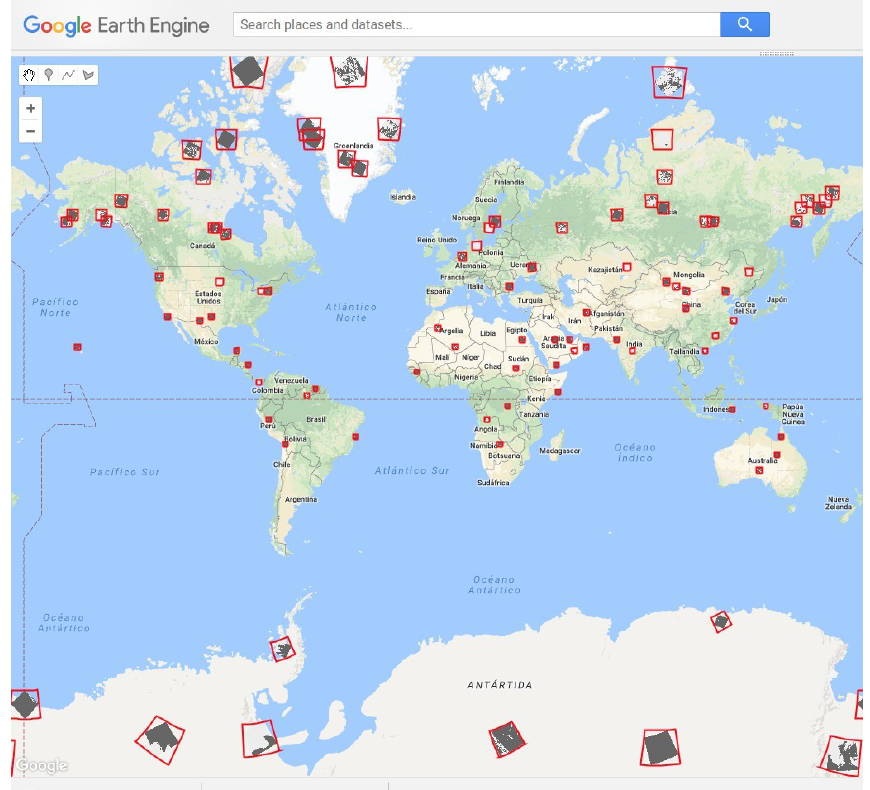
Figure 1. Geographic location of the 96 images from the Landsat-8 Biome dataset [31] ingested on the Google Earth